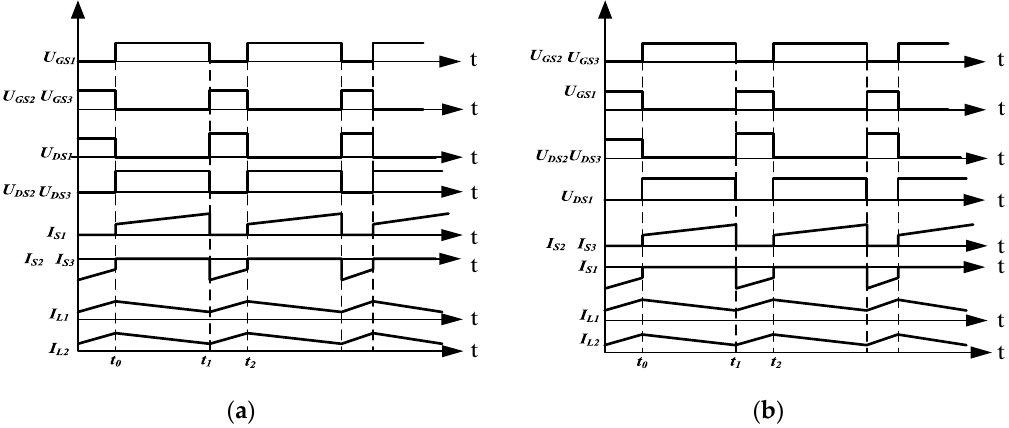
Figure 4. Main waveforms of ( a ) boost and ( b ) buck modes (converter I &II). (1) Boost mode of the converter